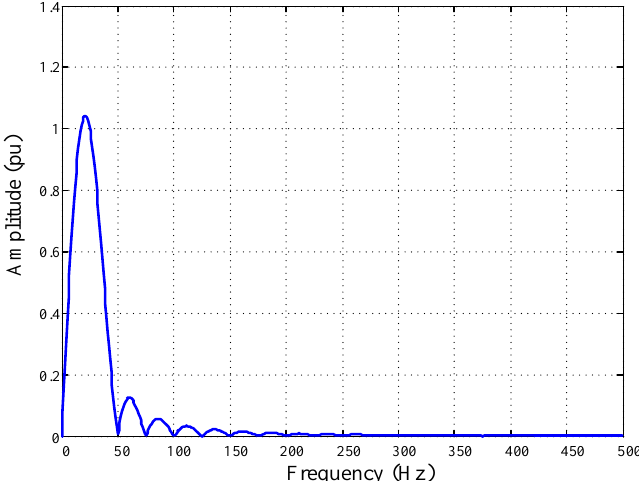
Figure 5. The frequency response of the sine window filter (double-cycle).